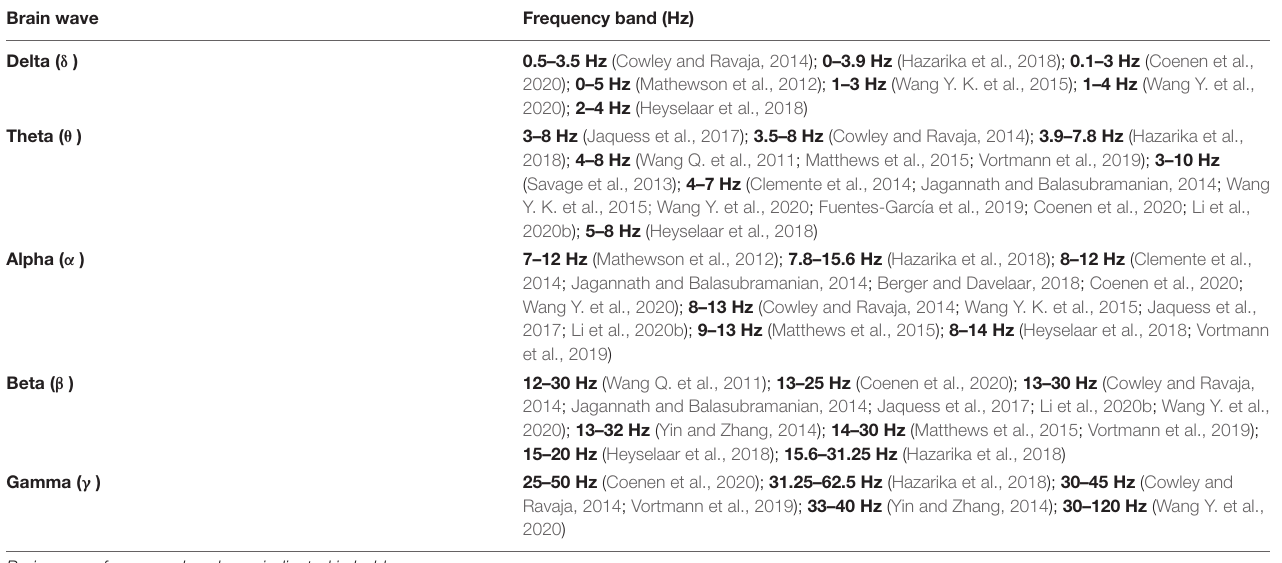
TABLE 1 | Brain waves and corresponding authors bands variations.